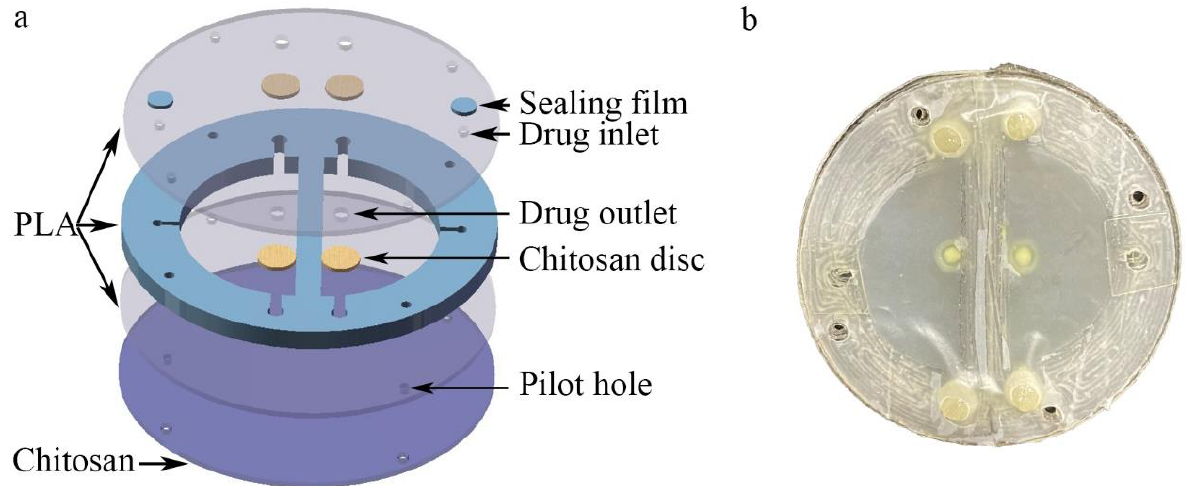
Figure 2. Structure of the microfluidic/chitosan device. ( a ) Three-dimensional exploded view of the device, from top to bottom: top PLA layer, drug reservoir, bottom PLA layer, and chitosan layer. ( b ) Photograph of the microfluidic/chitosan device.